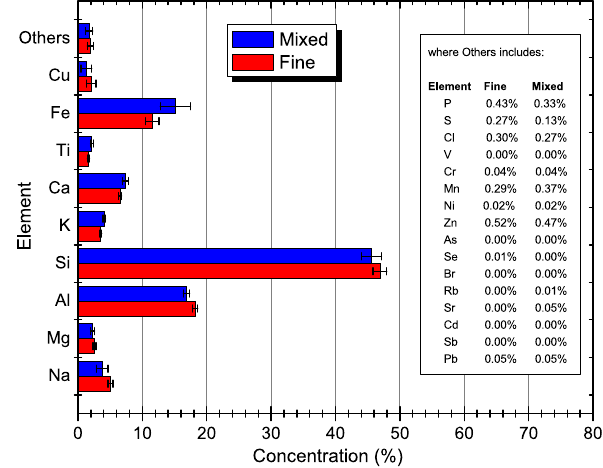
Figure 11. Fraction of the mass of each element in relation to the total collected mass. The error bars represent one standard deviation of the concentration measured for different